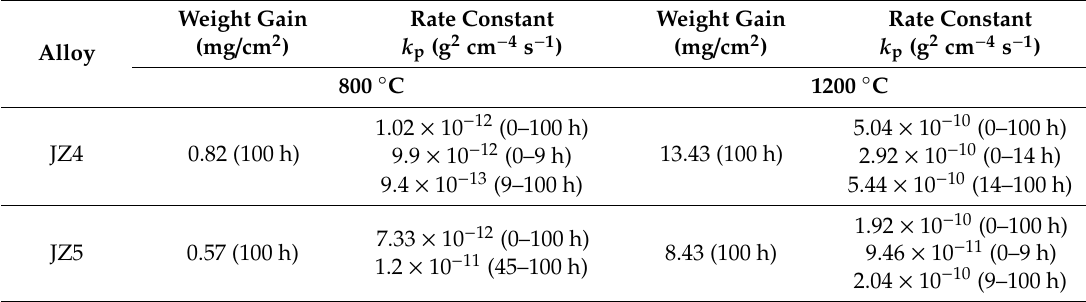
Table 3. Weight gains and parabolic oxidation rate constants of the alloys JZ4 and JZ5 after isothermal oxidation at 800 and 1200 ◦ C for 100 h.